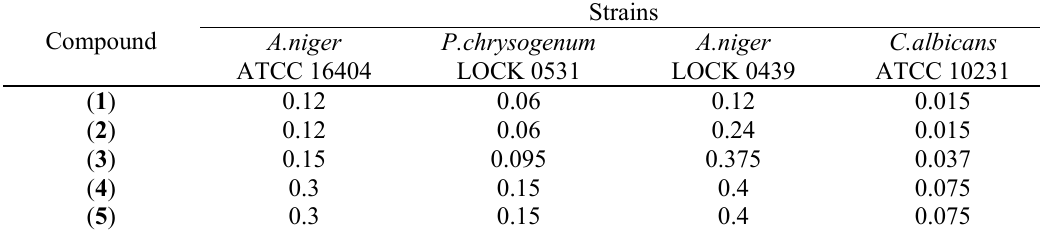
Table 3. The minimal inhibitory concentration (MIC) ( μ M/mL) of polymethylene- α , ω